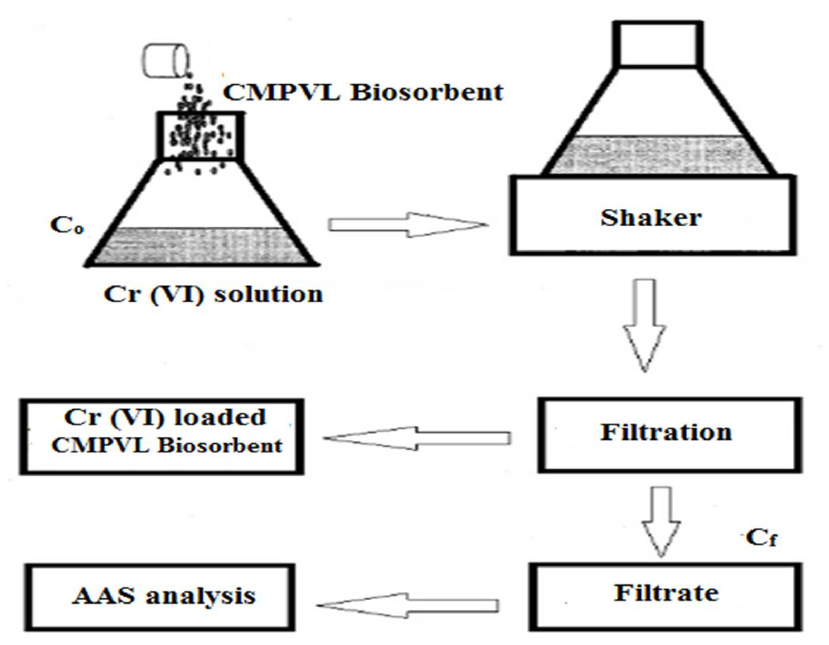
Figure 2. Scheme of batch biosorption experiment.